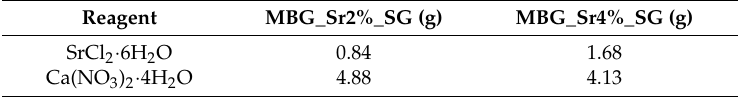
Table 2. Amounts of used salt precursors for MBG_Sr2%_SG and